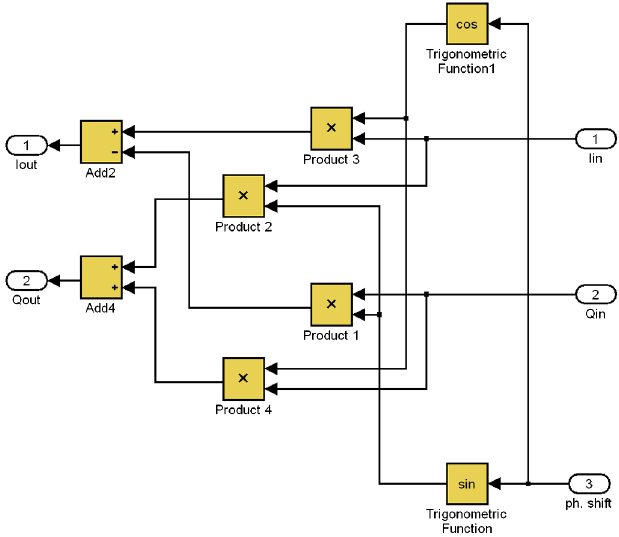
FIG. 11. MATLAB-SIMULINK model of the phase shifter.